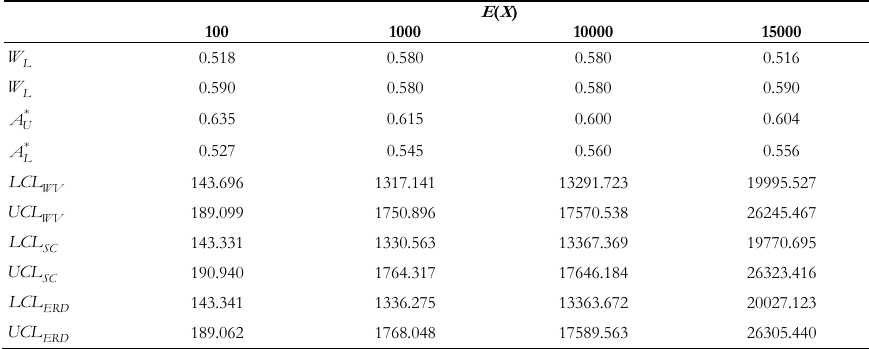
WV and SC constants and WV, SC and ERD control limits for cv(X)=0.01